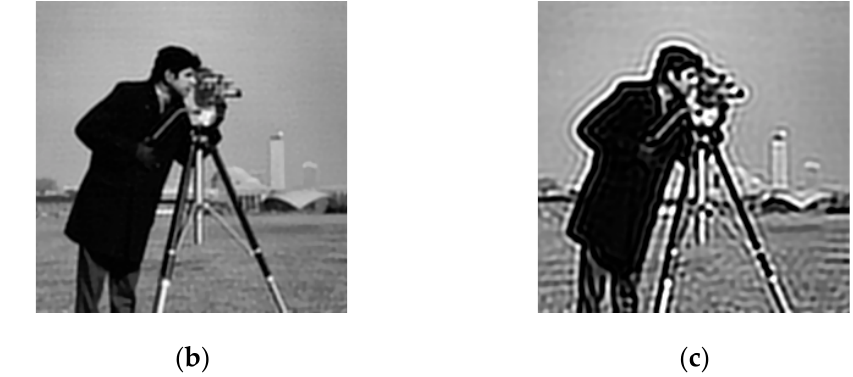
Figure 1. SR results using different blur kernels when the real blur kernel width is 1. ( a ) σ blur = 0.5; ( b ) σ blur = 1; ( c ) σ blur =